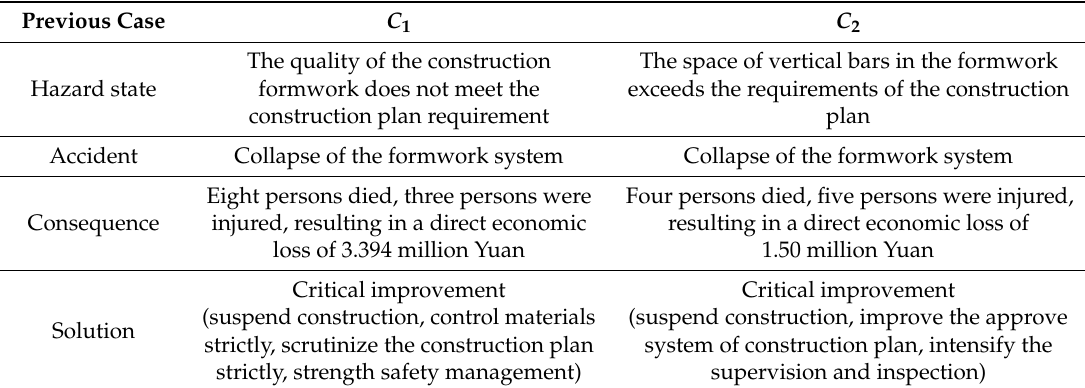
Table 5. Descriptions of previous C 1 and C 2 .